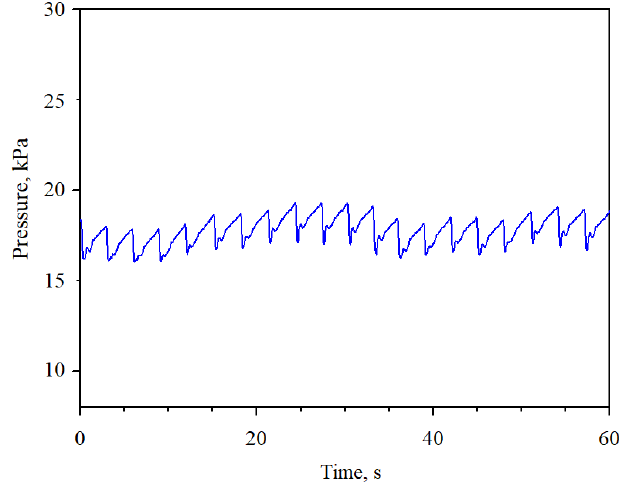
Figure 4. Measured pressure at riser-base during choking-induced bubbly flow ( U GS = 0.08 m/s and U LS = 0.09 m/s).